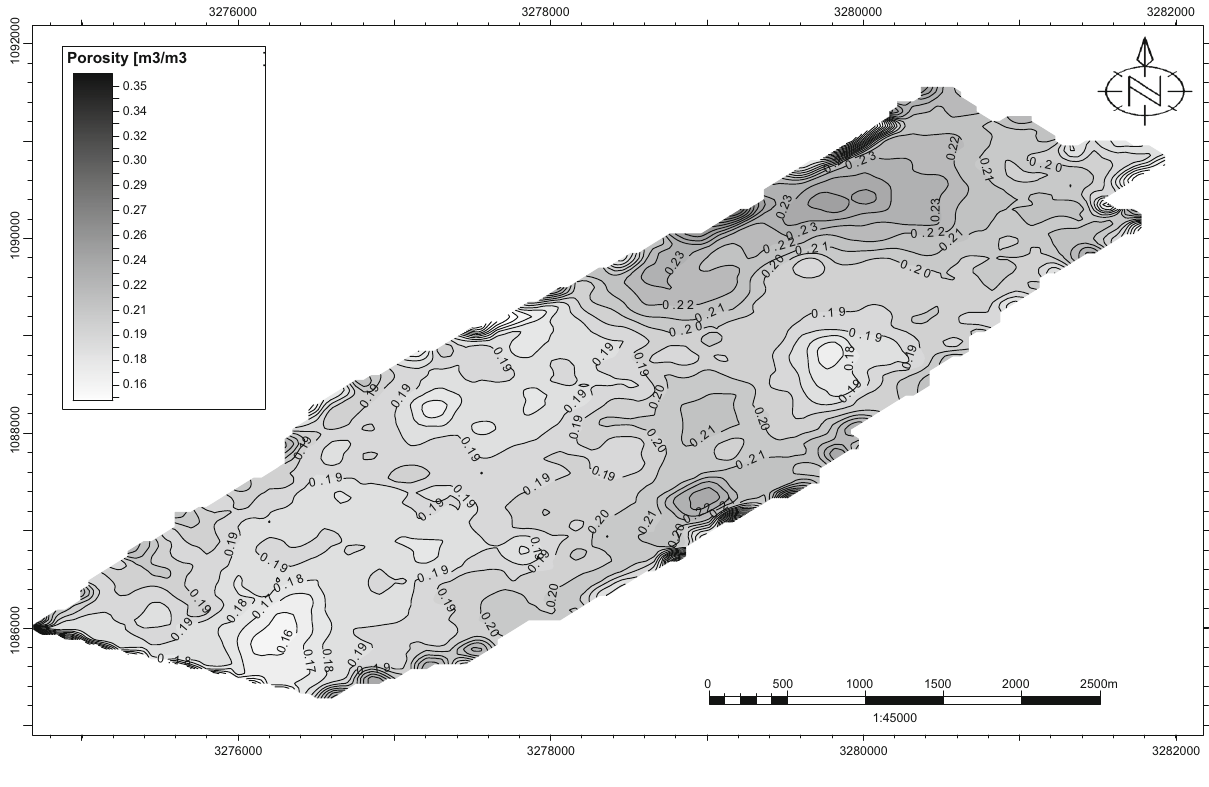
Fig. 4 Porosity distribution of the geomodel